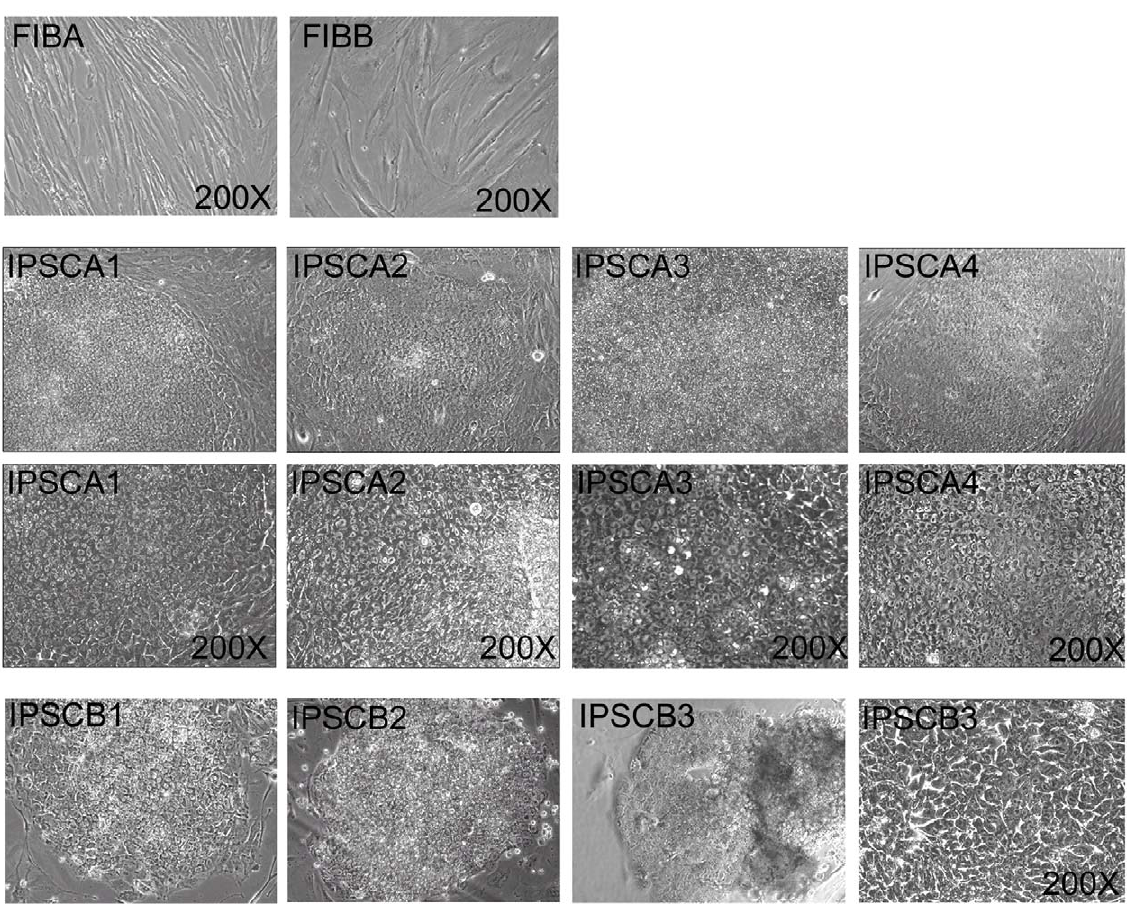
Figure 2. Phase-contrast images of FIB and IPSC lines used in this report (as labeled). FIBA and FIBB displayed a flat stellate cytoplasm with irregular edges characteristic of fibroblast cell types (200X). IPSC lines displayed round colonies with regular edges evident in low magnification 40X images that were composed of tightly packed cells with prominent nucleoli (200X, lower panels of IPSC lines) that appeared morphologically homogenous within the center of the colony and flattened toward the edges where they were bounded by the MEF feeder layer. IPSCB1 and IPSB2 are shown only at 40X magnification.